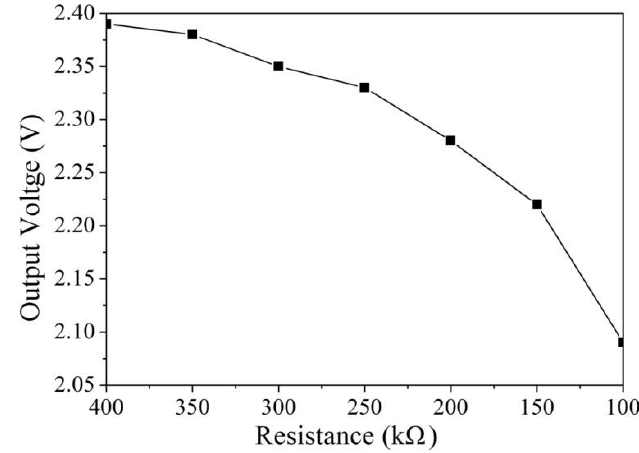
Figure 2. Simulated results of the output voltage for the readout circuit.